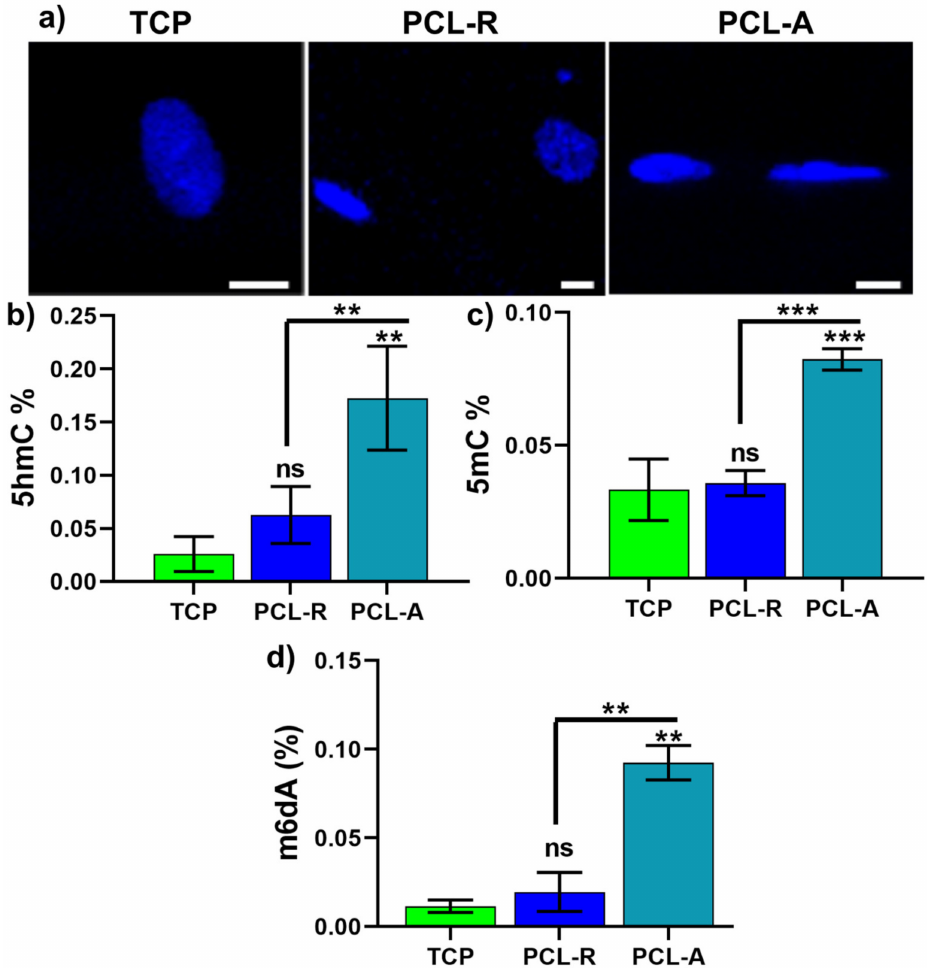
Figure 4. Representative nuclei ( a ), global 5mC ( b ), 5hmC ( c ), and m6dA ( d ) methylation changes in hOBs on different fiber aligned membrane after 24 h. Scale in ( a ): 50 µ m. m6dA: N-6 methylated deoxyadenosine; 5mC: 5-Methylcytosine; 5hmC: 5-Hydroxymethylcytosine. Data: mean ± SD. ** p < 0.02, *** p <